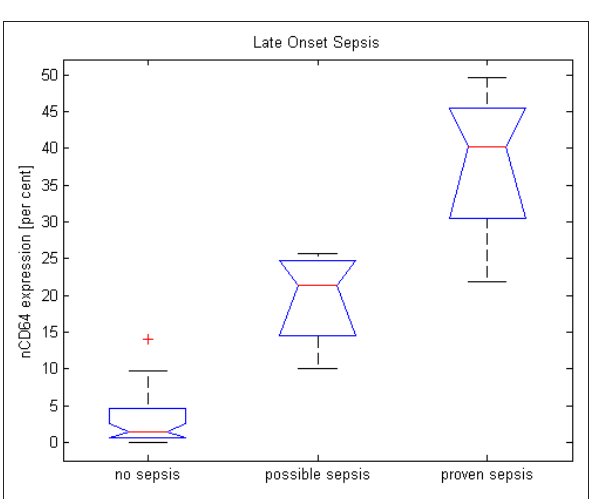
Fig. 3. Comparing nCD64 expression values between LOS cat- egories; the differences are significant at a level of P =0.0001.